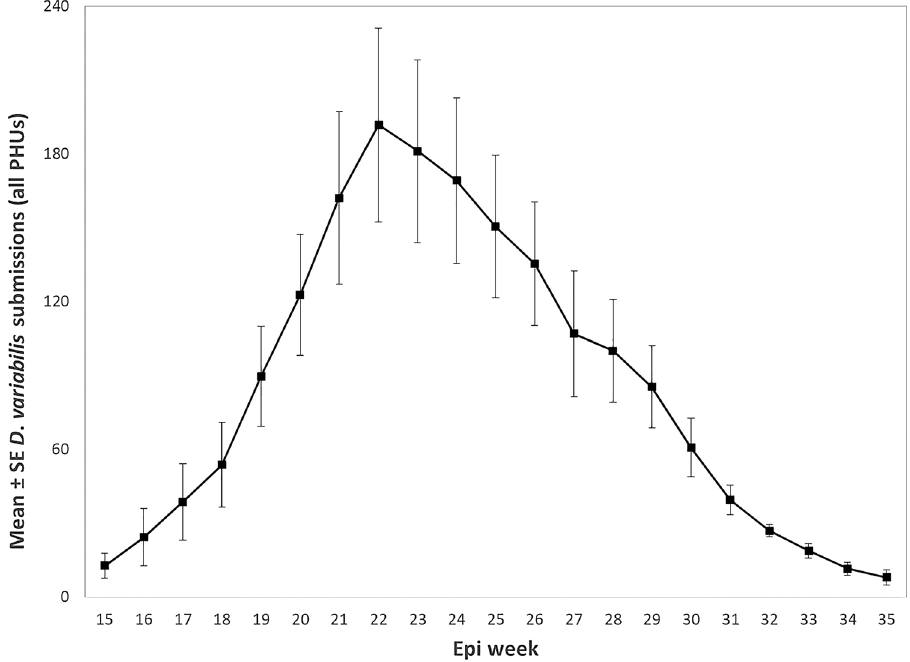
Figure 1. Dermacentor variabilis submissions per epidemiological week (epi week) for all public health units (PHUs) during the spring and summer: Ontario, Canada (2010–2018). Epi week 22 starts May 25–31, depending on